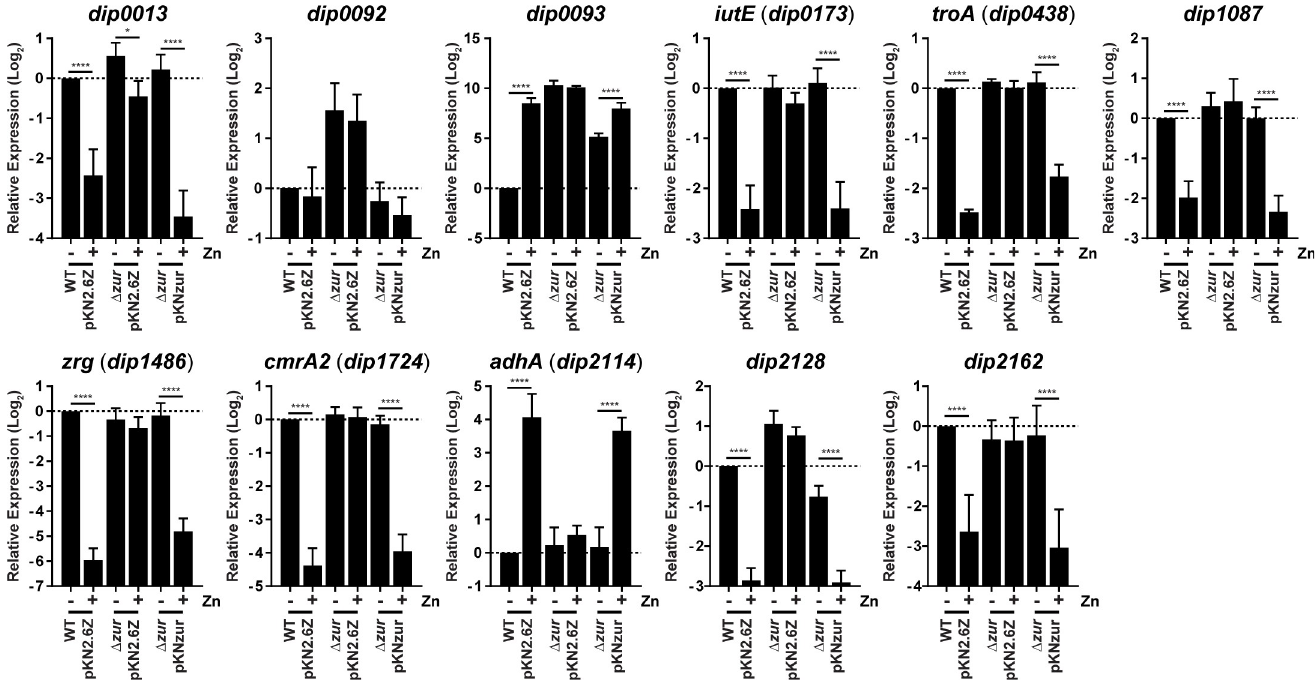
Fig 2. Complementation of the zur deletion restores wild-type levels of expression to zinc- and Zur-regulated genes. RNA that was harvested from various C . diphtheriae strains grown in mPGT without (-) and with (+) 5 μ M zinc (Zn) supplementation was used for RT-qPCR. C . diphtheriae strains include; wild-type C . diphtheriae carrying vector pKN2.6Z (WTpKN2.6Z) and the zur mutant carrying either the vector pKN2.6Z ( Δ zur pKN2.6Z) or the complementing plasmid containing the zur gene, pKNzur ( Δ zur pKNzur). Relative expression of indicated genes was compared using the ΔΔ Cq method whereby gyrB expression was used for normalization, and the wild-type strain without added zinc [WT (-)] was used for comparison. The data are the mean and standard deviation of three biological replicates; significance was determined by 2way ANOVA, Holm-Sidak’s multiple comparisons test: ���� indicates p < 0.0001; � indicates p < 0.05.